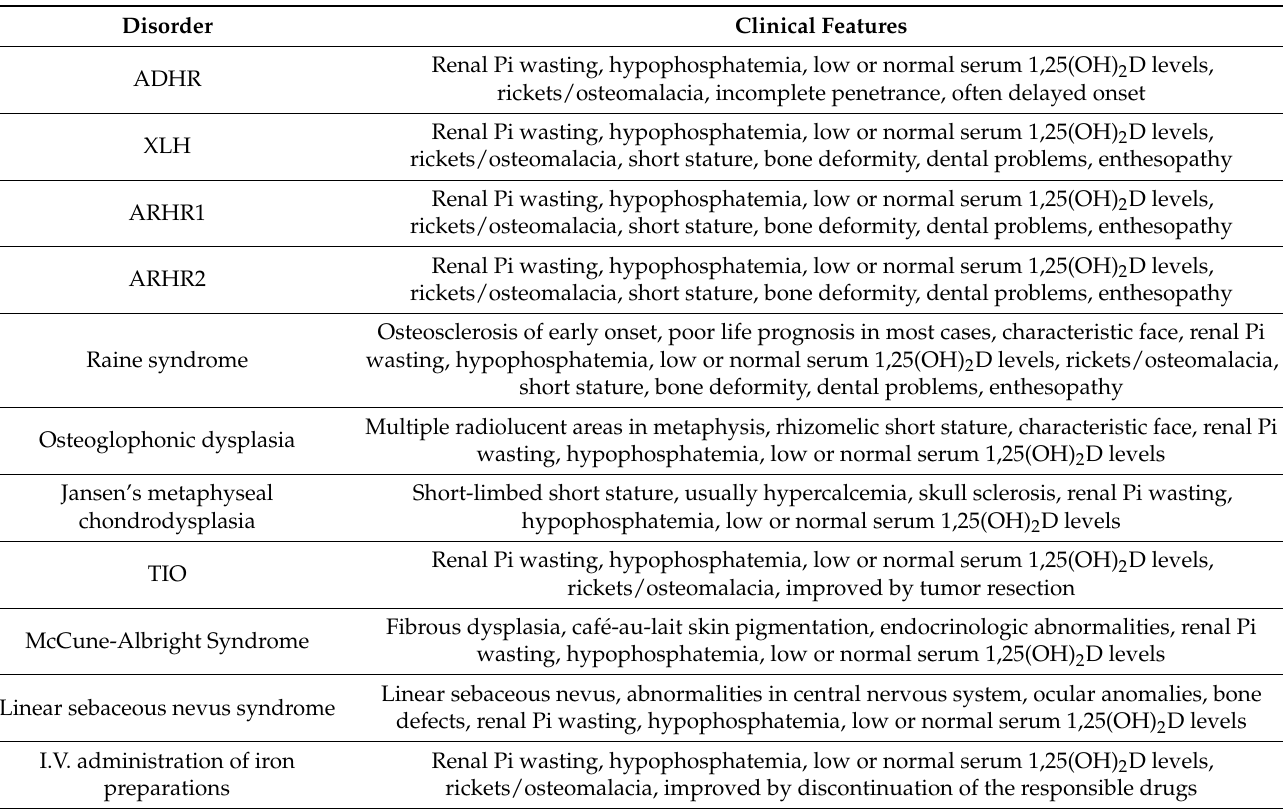
Table 2. Clinical features of FGF23-related hypophosphatemic